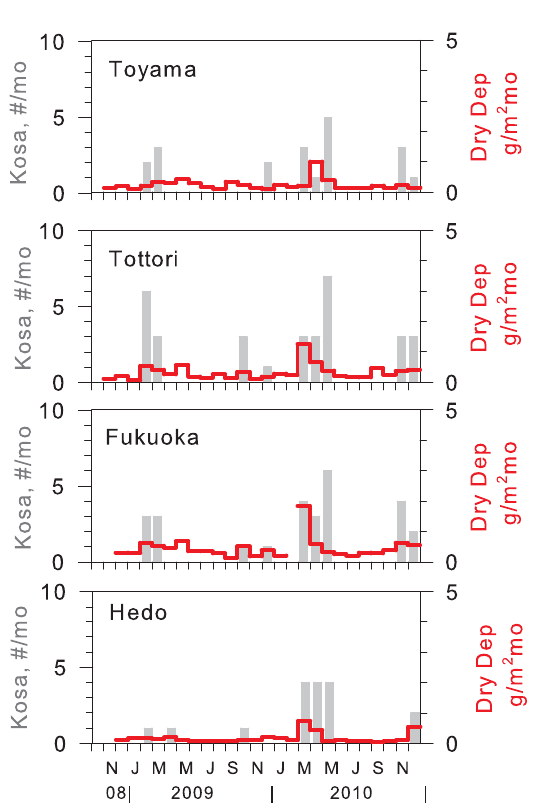
Fig. 5. Monthly numbers of Kosa days near the sites (gray) and monthly dry deposition fluxes